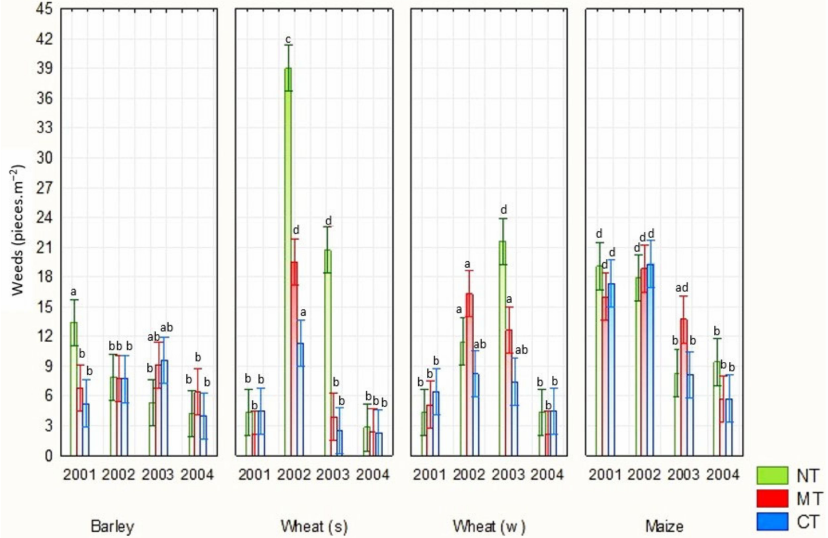
Figure 1. Intensity of weeding in the observed tillage variants, in the cultivated crops, and in the observed years. The results represent the mean of 25 biological replicates ± SE. Identical letters express statistical non-significance between the variants, different letters express statistical signifi- cance at a significance level p = 0.05 (Fisher LSD test). The plot shows the mean, whiskers represent the standard error, values with different letters (a, b, c, d) differ significantly. Variants of tillage technologies: CT—conventional tillage; MT—minimum tillage; NT—no